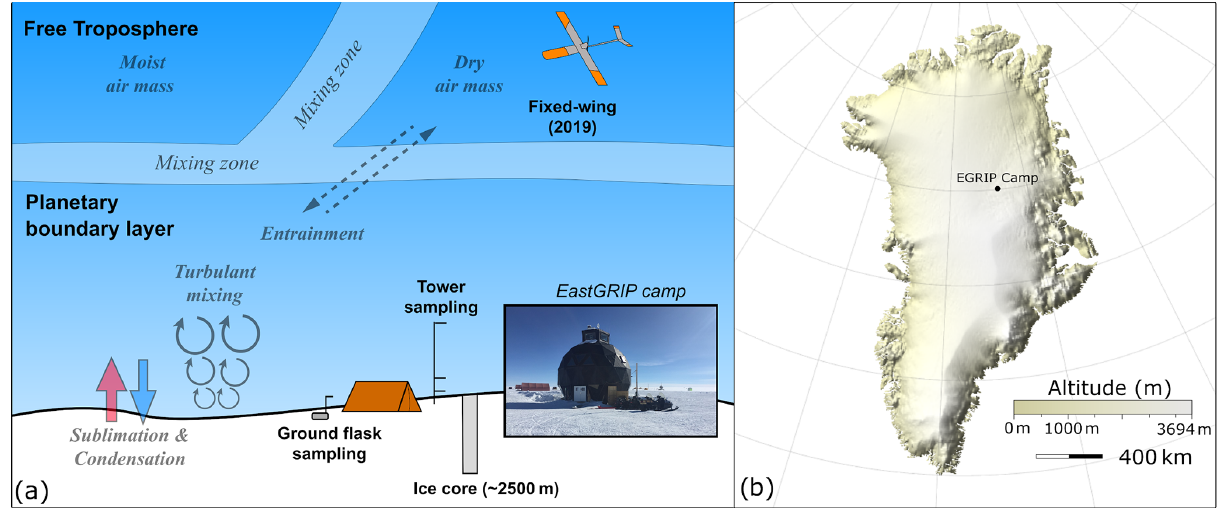
Figure 1. (a) Overview of the local hydrological cycle (excluding precipitation events) at the EastGRIP ice core camp. The water isotope sampling projects at EastGRIP in 2019 included ice core drilling, surface snow/ice sampling, continuous measurements of atmospheric air from a ∼ 7m tower, and UAV sampling of atmospheric air. (b) Location of the EastGRIP ice core camp on the Greenland Ice Sheet at 75.6 ◦ N, 35.9 ◦ W (Wolfram Research,